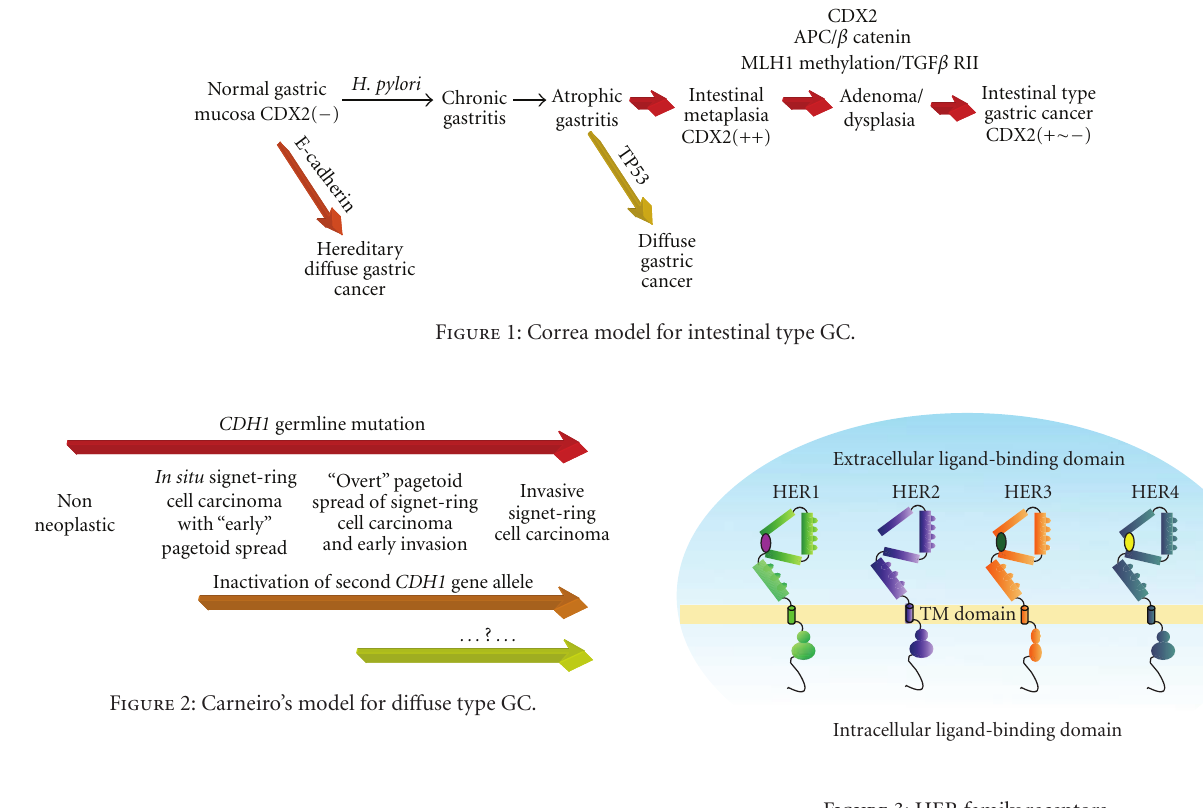
Figure 3: HER family